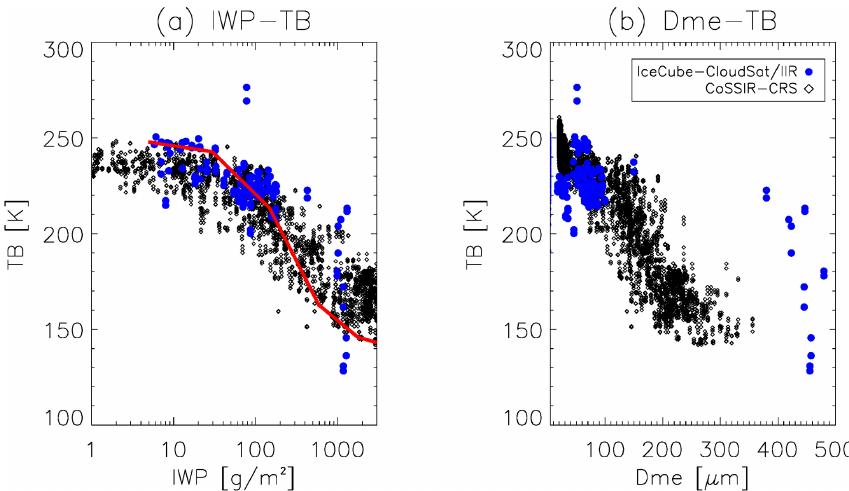
Figure 9. (a) IWP–TB and (b) D me –TB relationship derived from collocated CoSSIR–CRS measurements (black dots) during the TC4 campaign. Note that IWP here is the partial column integration from 9km above. IceCube–CloudSat–IIR data from Fig. 8 are overlaid as blue dots with a warm offset of 10K added. ARTS simulation (red curve) is added as the